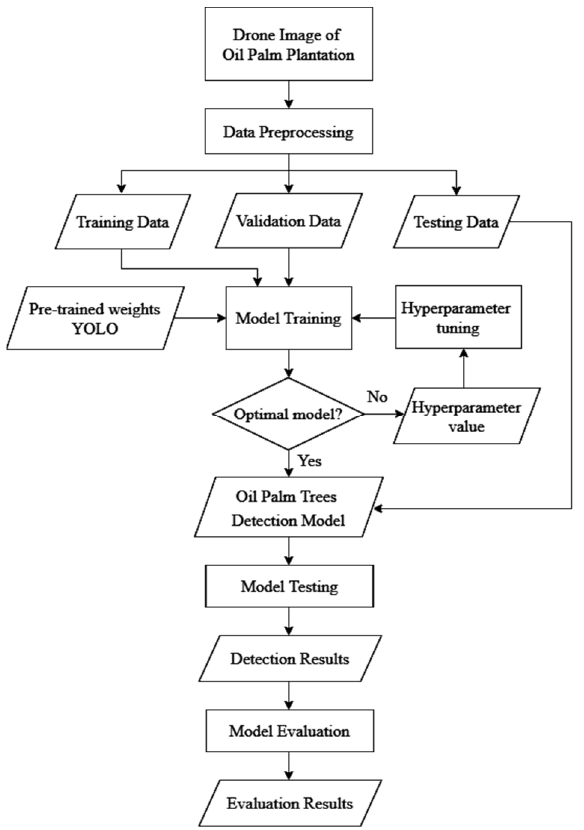
Figure 1. Research plan in this study.